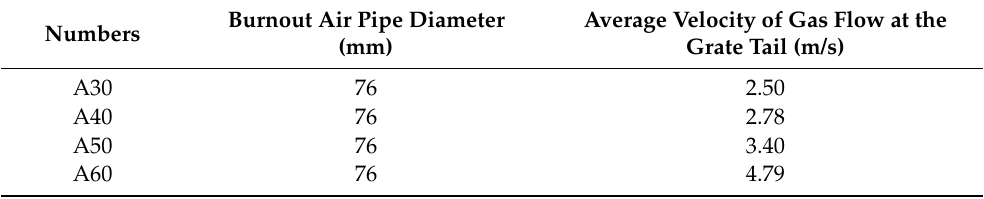
Table 4. Variation of flow field at the grate tail at different flow